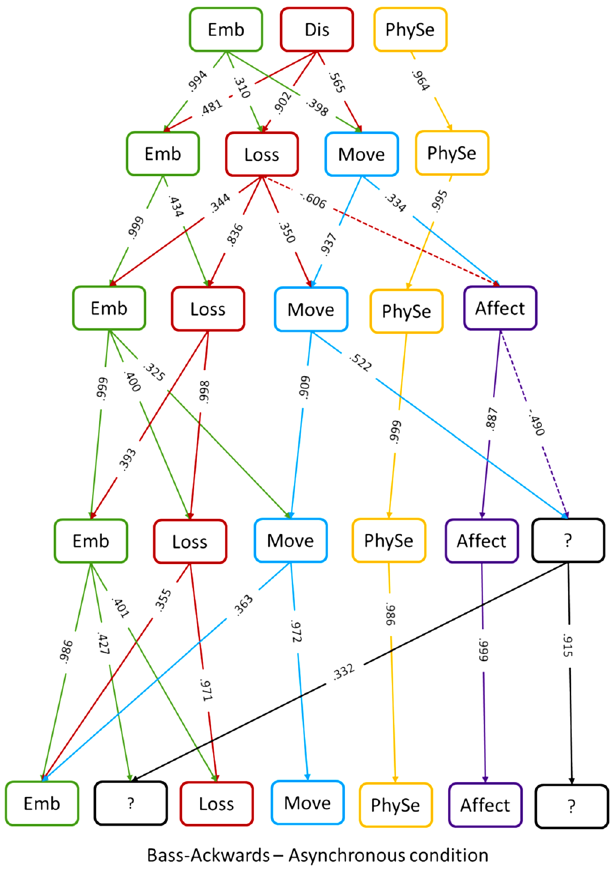
Figure 4. Results of the Bass–Ackwards procedure on the items after asynchronous stimulation. The correlations between the components of different solutions are represented. Negative correlations are reported with dash lines, while positive correlations are in solid lines. Components’ names are abbreviated: Emb embodiment, Dis disembodiment, PhySe physical sensations, Loss loss-of-own-hand, Move